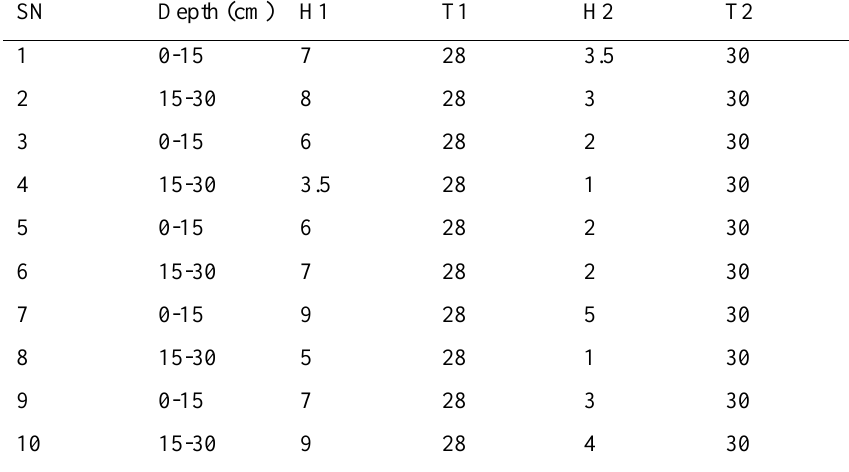
Bouyoucos hydrometer and thermometer reading for the soil samples. SN Depth (cm) H1